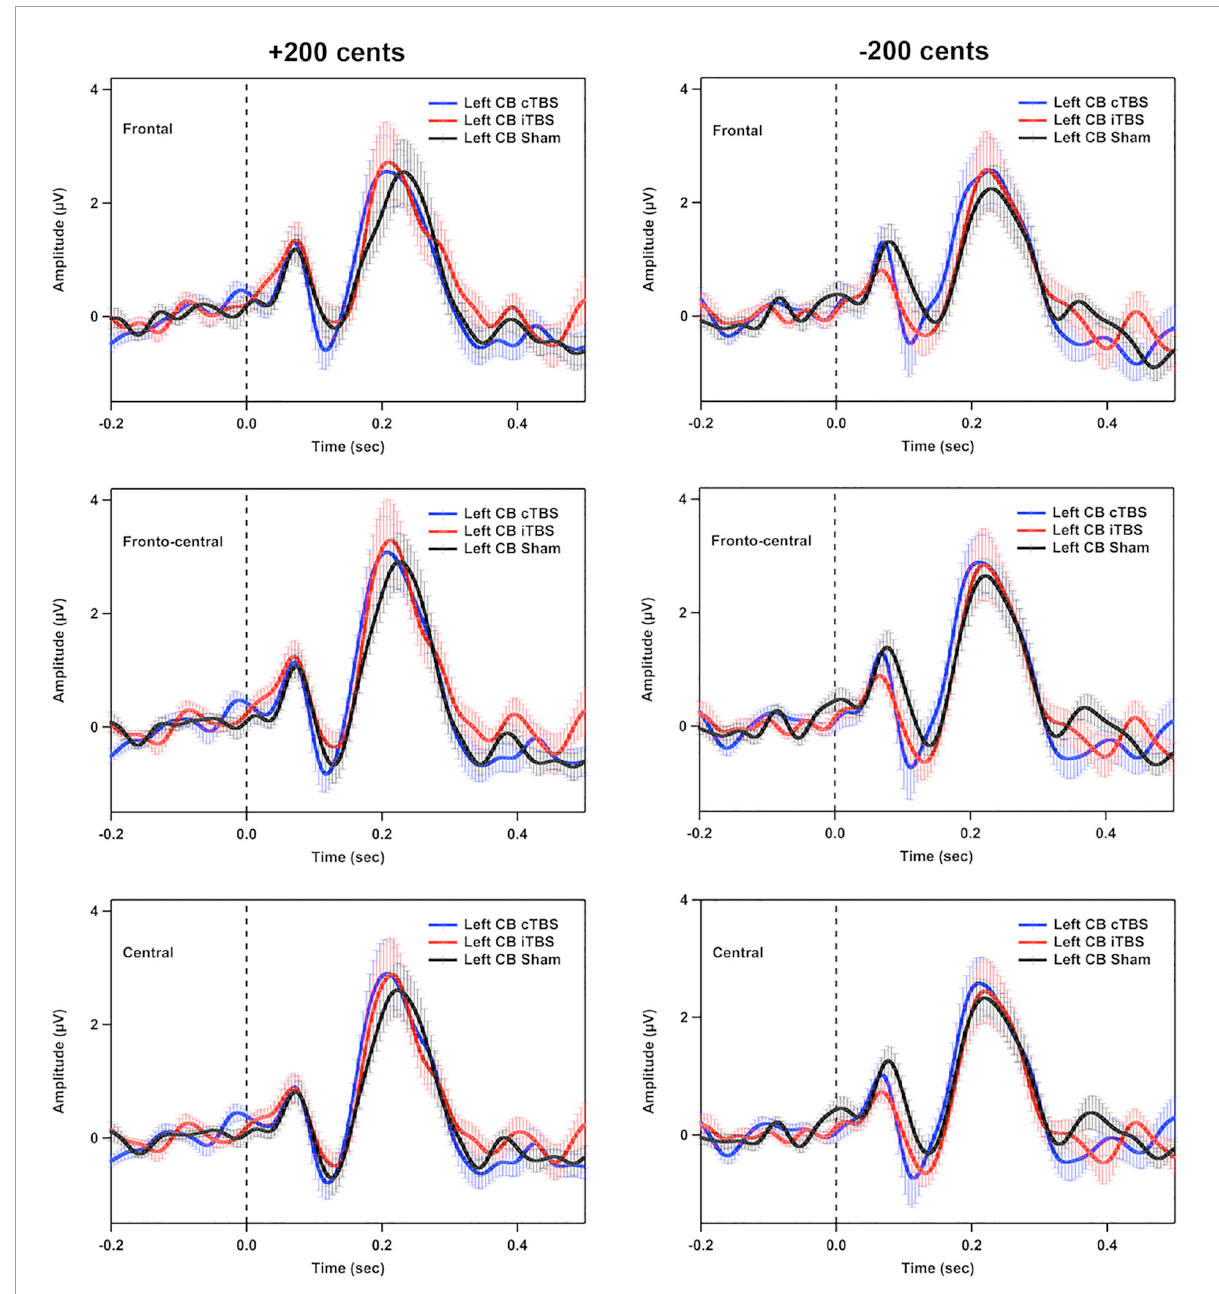
FIGURE5 Grand-averaged event-related potential (ERP) waveforms across all participants in responses to pitch perturbations of ± 200 cents in the frontal, fronto-central, and central regions following cTBS, iTBS, and sham stimulation over the left cerebellar lobule VII (Crus I). Time 0 represent the onset of pitch perturbations. CB,